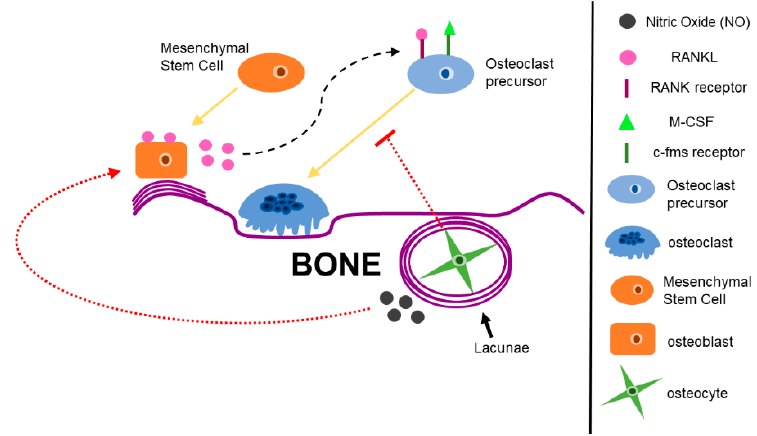
Figure 2. Osteoblasts, osteoclasts, and osteocytes are key modulators in the bone microenvironment. Osteoblasts derived from mesenchymal stem cells and are responsible for bone building. Osteoblasts have bound and soluble forms of receptor activator of nuclear-factor kappa- β ligand (RANKL), a key factor needed for osteoclast differentiation. Secreted RANKL can bind to the receptor activator of nuclear-factor kappa- β (RANK) receptor on osteoclast progenitor cells and initiate differentiation of osteoclast precursors. Osteoclasts are derived from a monocyte/macrophage lineage. Along with soluble RANKL, macrophage-colony stimulating factor (M-CSF) binds to the colony-stimulating factor-1 (C-FMS) receptor on osteoclast progenitors to initiate osteoclast differentiation. RANKL and M-CSF are the two key factors in osteoclast differentiation and formation. Once osteoclastogenesis is initiated, mono-nucleate osteoclast precursors fuse together to form multi-nucleate, mature osteoclasts. Osteocytes are terminally differentiated osteoblasts that have become embedded in the bone matrix. Osteocytes secrete factors in response to mechanical strain, including nitric oxide, which can activate osteoblast bone formation or inhibit osteoclast formation and bone resorption.